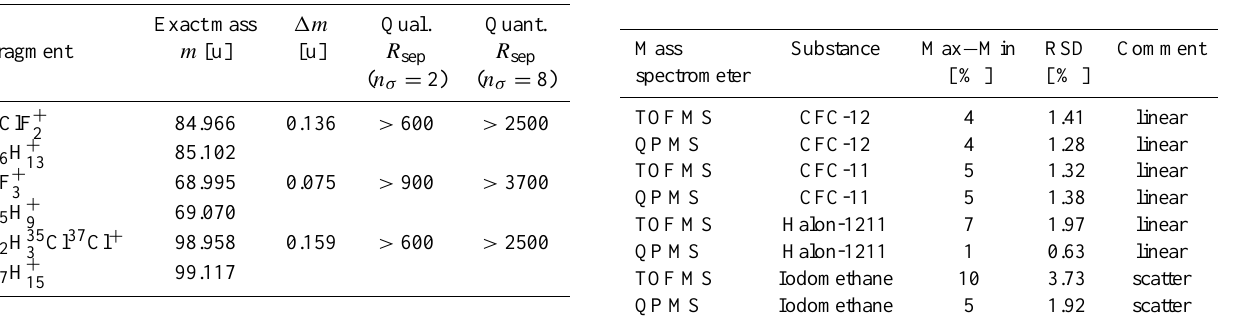
Table 3. Three exemplary halocarbon/hydrocarbon fragment pairs with equal unit mass but differing exact mass. The qualitative sepa- rating resolution (qual. R sep ) with n σ = 2 and the quantitative sep- arating resolution (quan. R sep ) with n σ = 8.